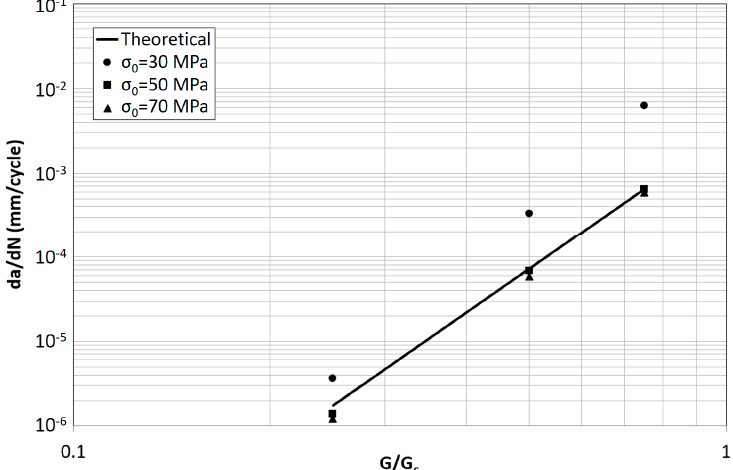
Figure 8. Theoretical and predicted FCG rate for different values of σ 0 and G/G c (K 0 = 10 5 MPa/mm).